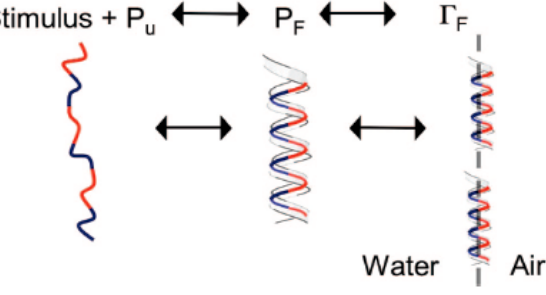
Figure 9. Folding initiated interfacial dynamics. Pu is the population of the unfolded peptide and Pf is for the folded peptide. Blue = hydrophilic, Red =